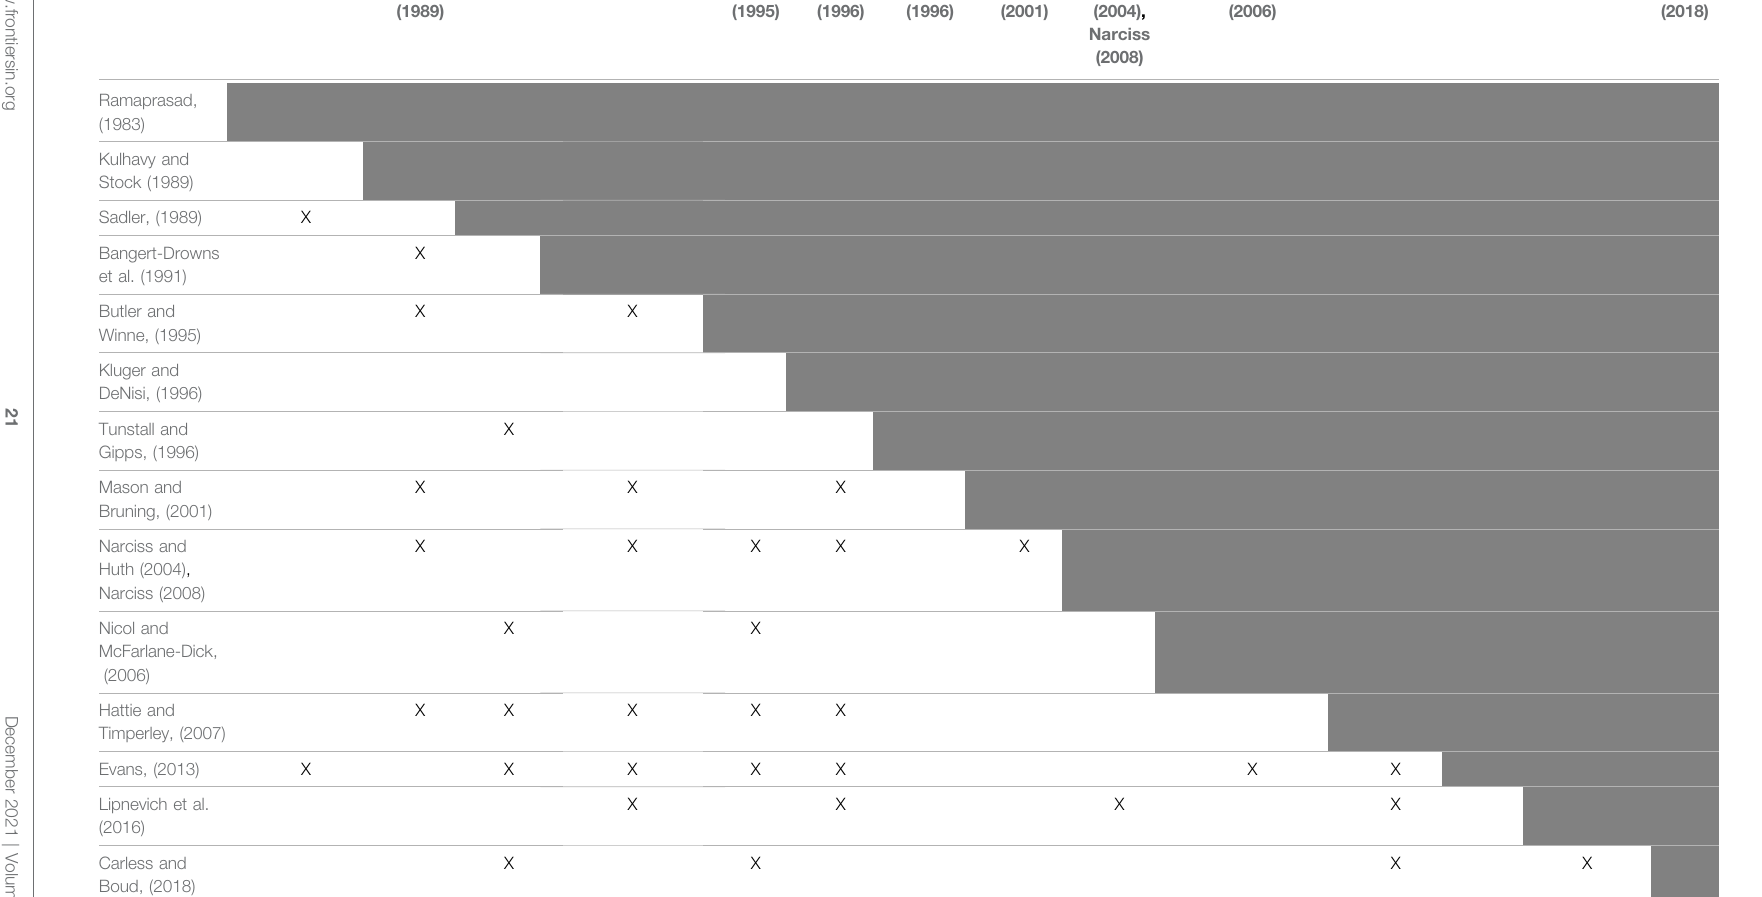
X X X X X indicates that an article in the left-most column includes a citation to the article in the top